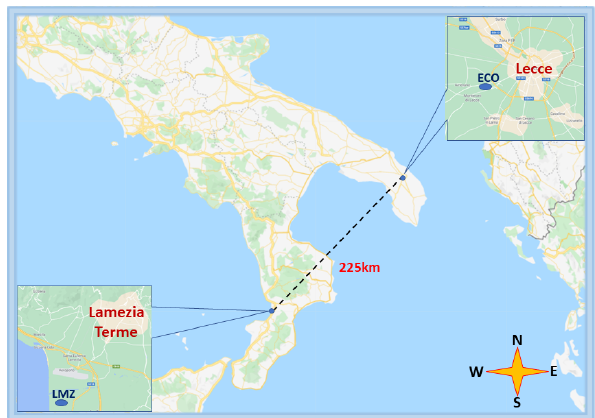
Figure 1. Map of the examined area with the locations of the two environmental–climate observatories, ECO and LMT. The map was retrieved from Google (map data ©